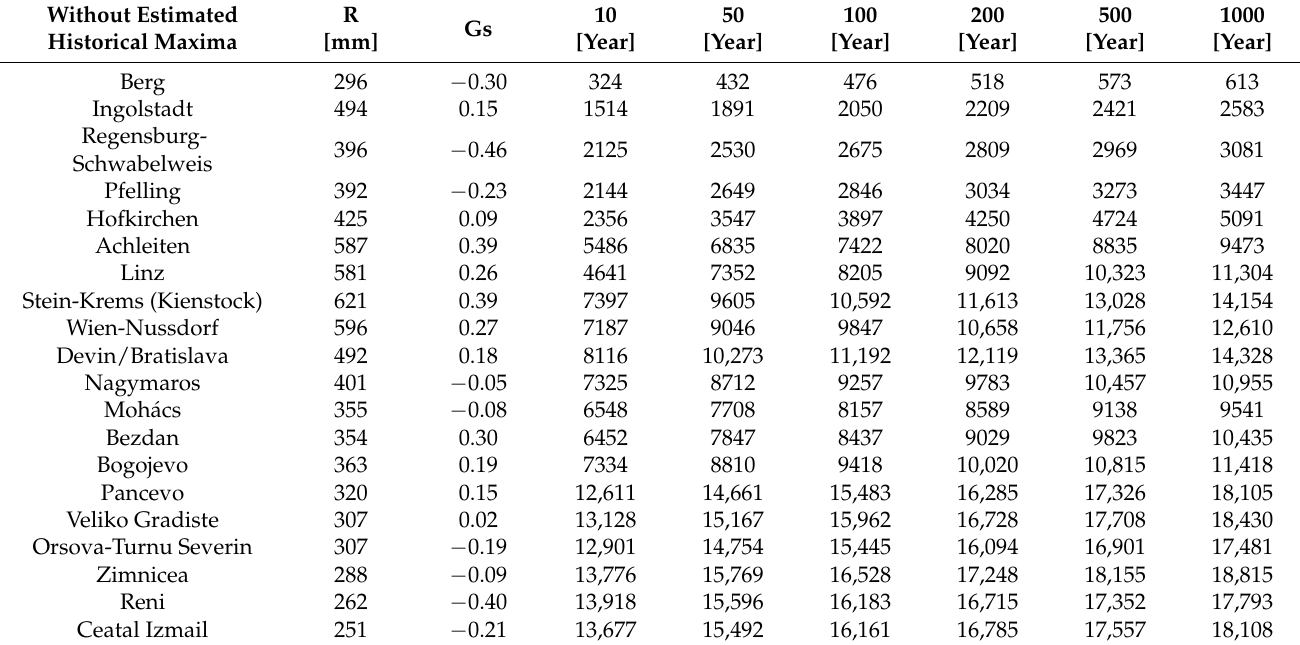
Table 2. Design values of selected T -year annual maximum discharges in [m 3 s − 1 ] along the Danube River (R: runoff depth, Gs: station skew coefficient).